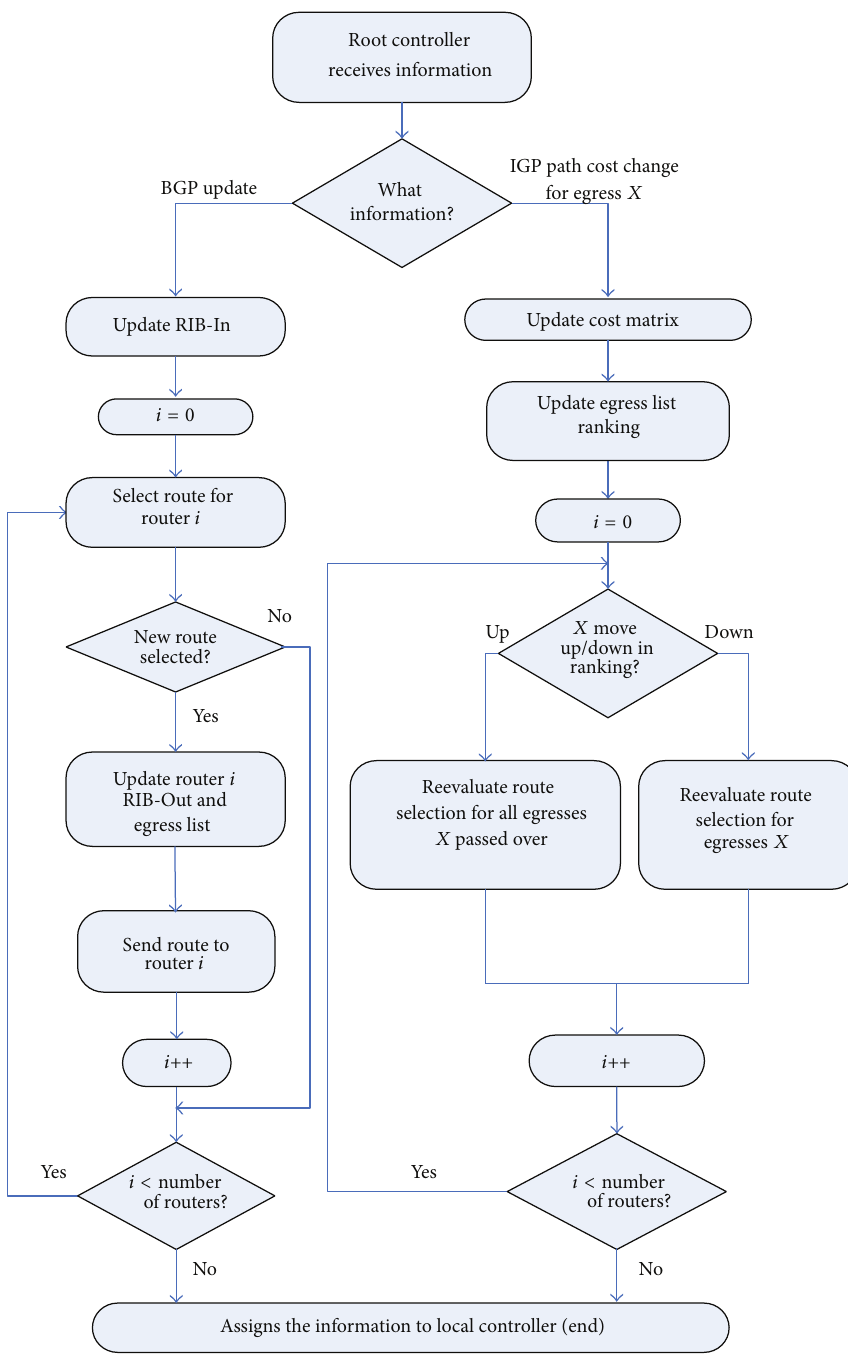
Figure 4: The implementation process of BGP protocol on